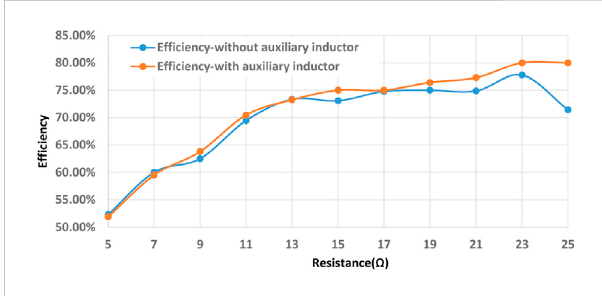
FIGURE 16 The comparison of the inverter ef fi ciency by adding the auxiliary inductor and without using the auxiliary